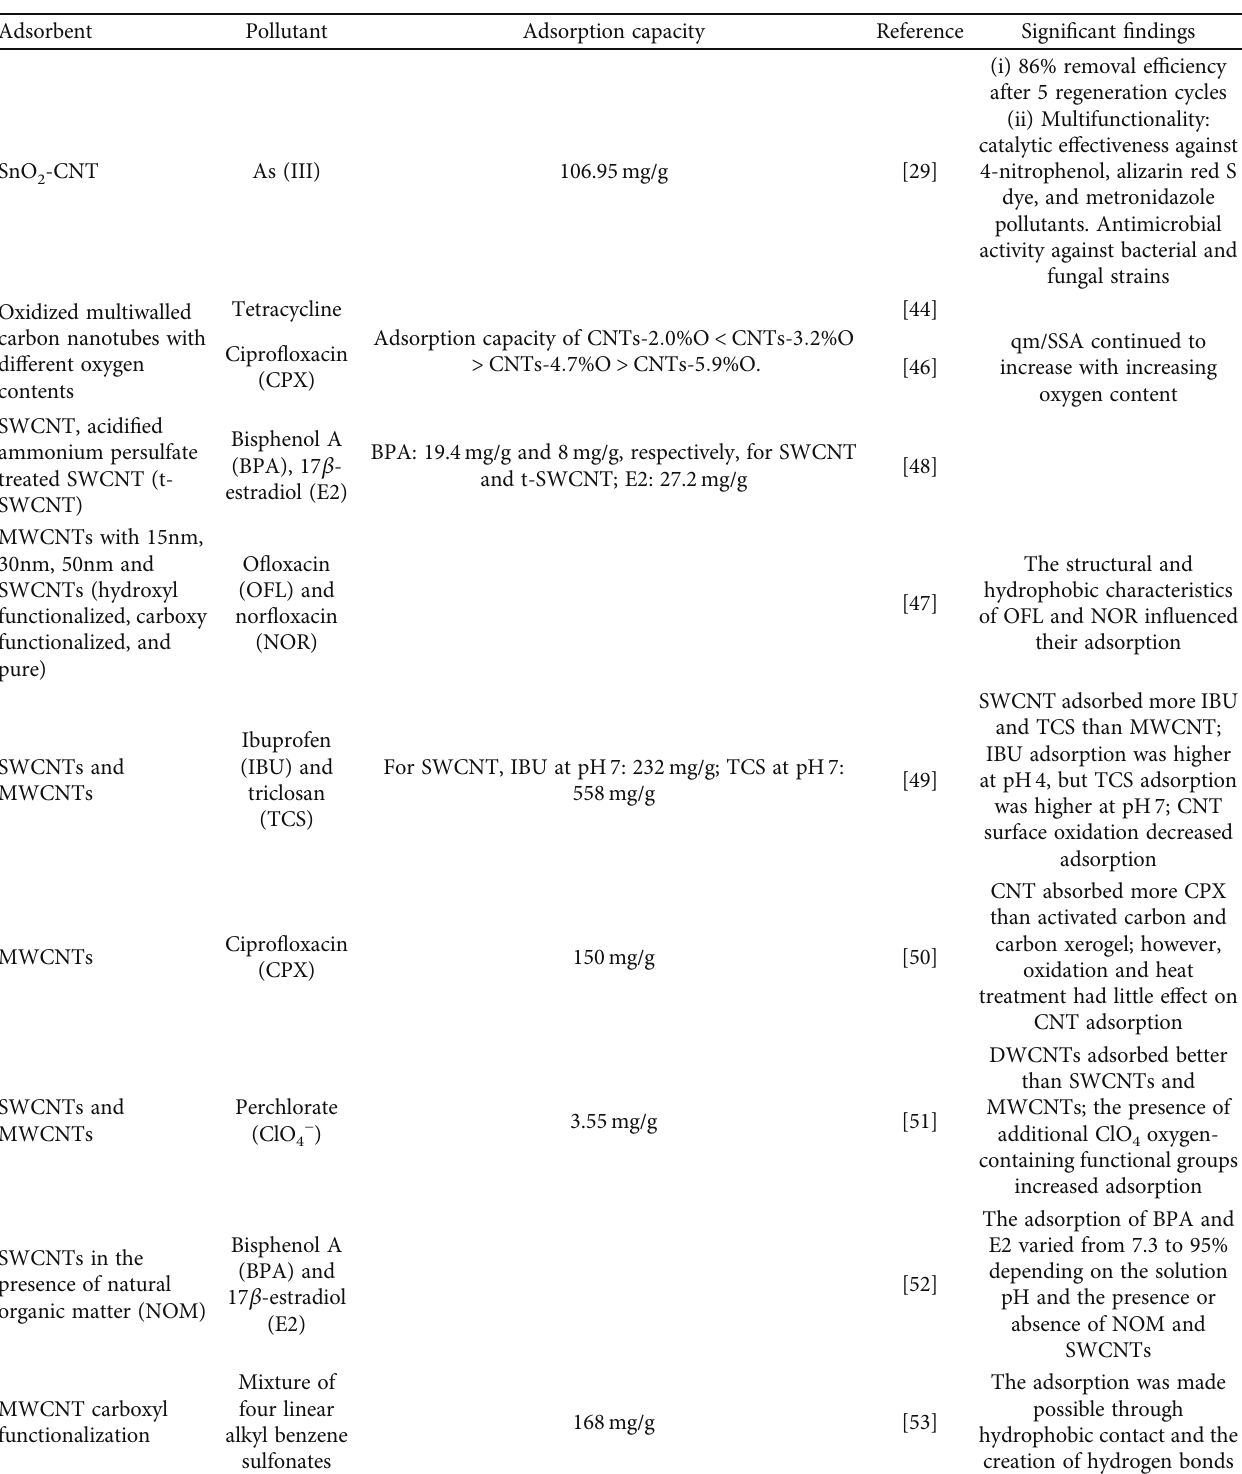
Table 1: Removal of emerging contaminants by CNT-based